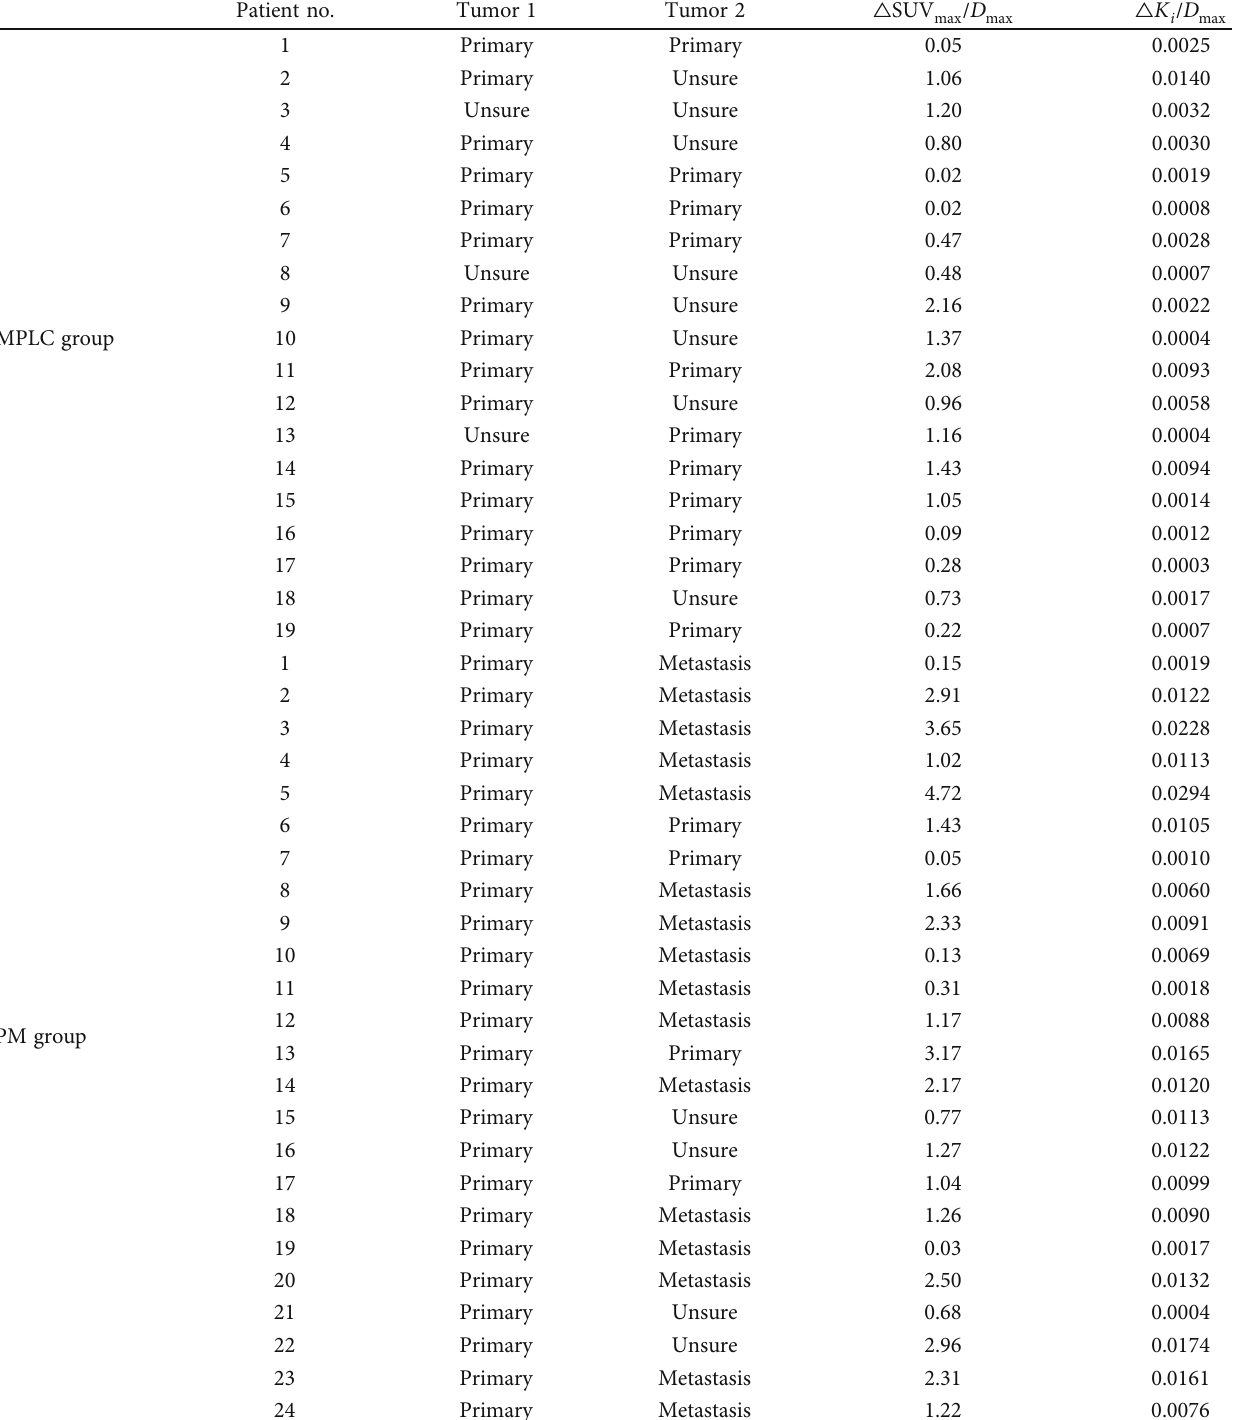
Table 5: Diagnostic results based on CT characteristics. Patient